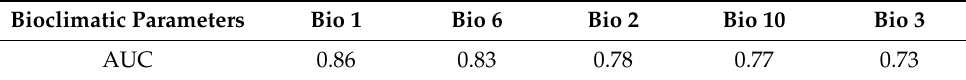
Table 3. Parameters of AUC for H. rufipes for each ecological factor, obtained using Iackknife method.